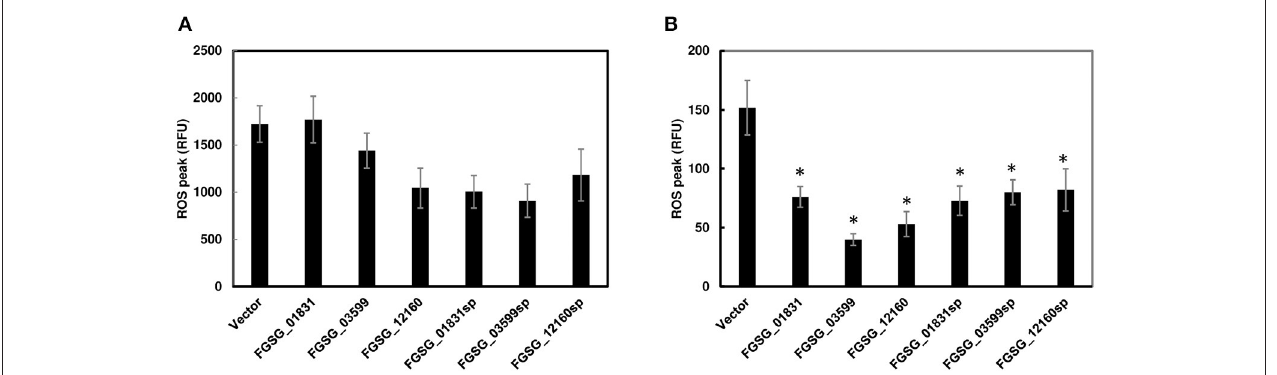
FIGURE 6 | Reactive oxygen species (ROS) production in N. benthamiana leaves infiltrated with Agrobacterium strain GV2260 carrying F. graminearum effector genes or an empty vector. (A) ROS induced by flg22; (B) ROS induced by chitin. Luminescence was measured in 200 µ L of assay solution (17mM lumino, 1 µ M horseradish peroxidase, and 100nM flg22 or 200 µ g/mL crab shell chitin) for 60min. Leaves infiltrated with an empty vector served as positive controls. Bars represent the means of 12 replicates. Error bars represent the standard error of the mean (SEM). Statistical significance compared to N. benthamiana leaves infiltrated with an empty vector is indicated by asterisks (one-way ANOVA and Tukey post-hoc test, P < 0.05). The assays were repeated at least three times with similar results.